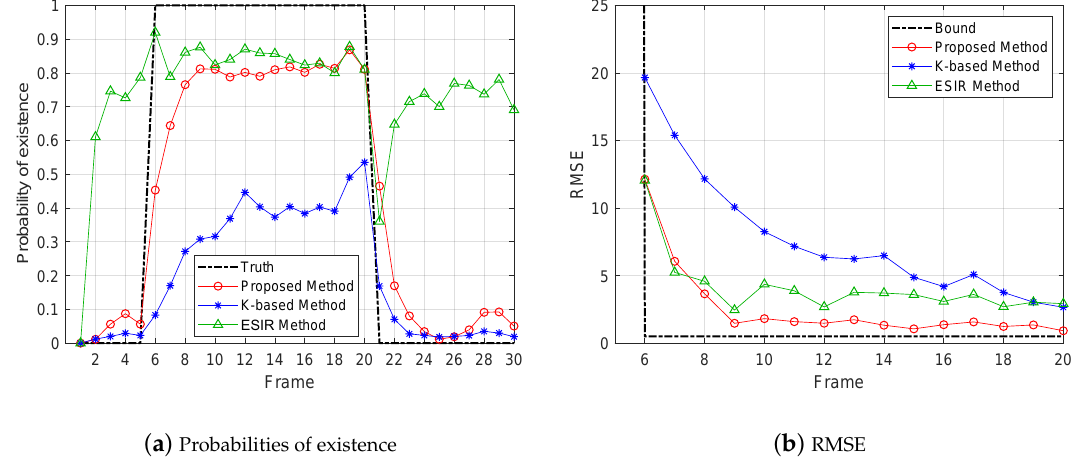
Figure 10. Probabilities of existence and Results of RMSE in case of SCR = 12